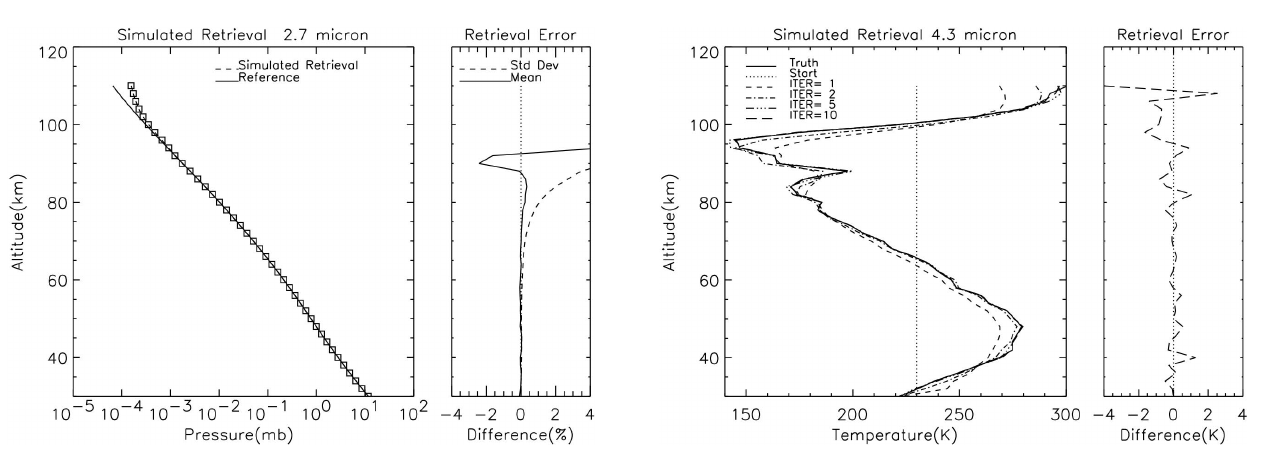
Fig. 14. Same as Fig. 13 but for pressure.